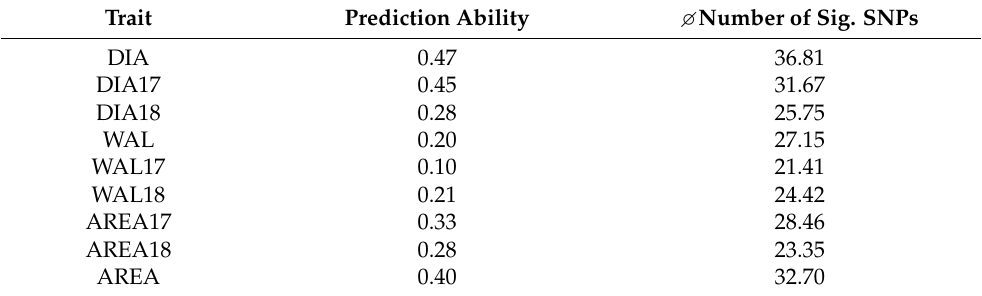
Table 3. Mean number of significant single nucleotide polymorphisms (SNPs) and cross-validated prediction ability obtained by those SNPs, for the traits DIA, WAL, and AREA. Data for single trial years and BLUEs.